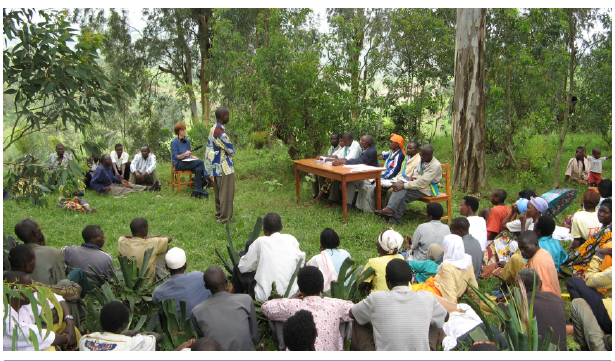
Fig. 4 . Gacaca courts were mostly held outside on the